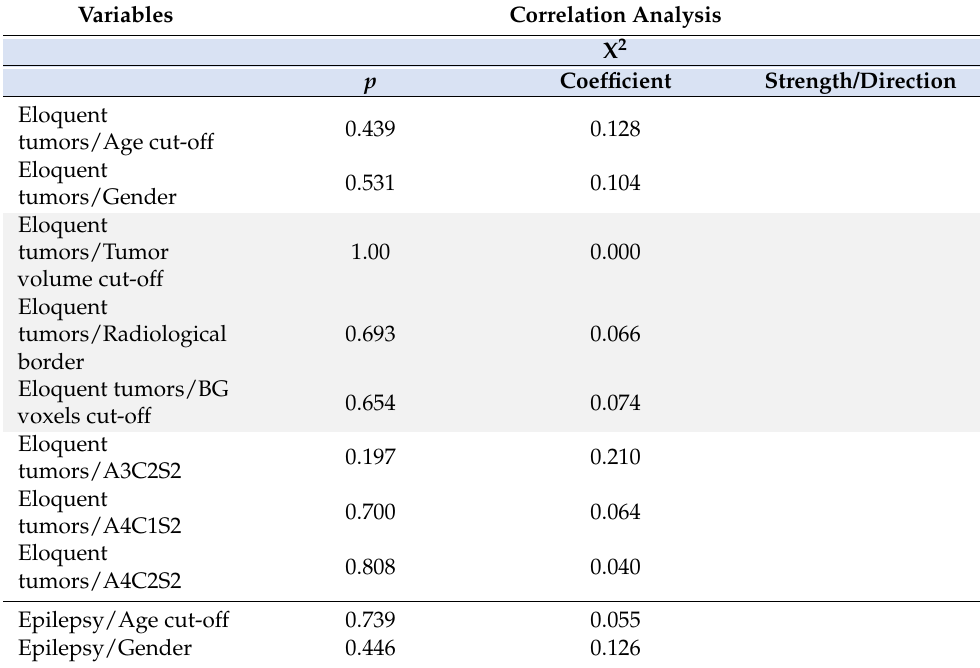
Table 4. Summary of the correlation between categorical and dichotomous variables with Pearson’s chi square analysis and contingency